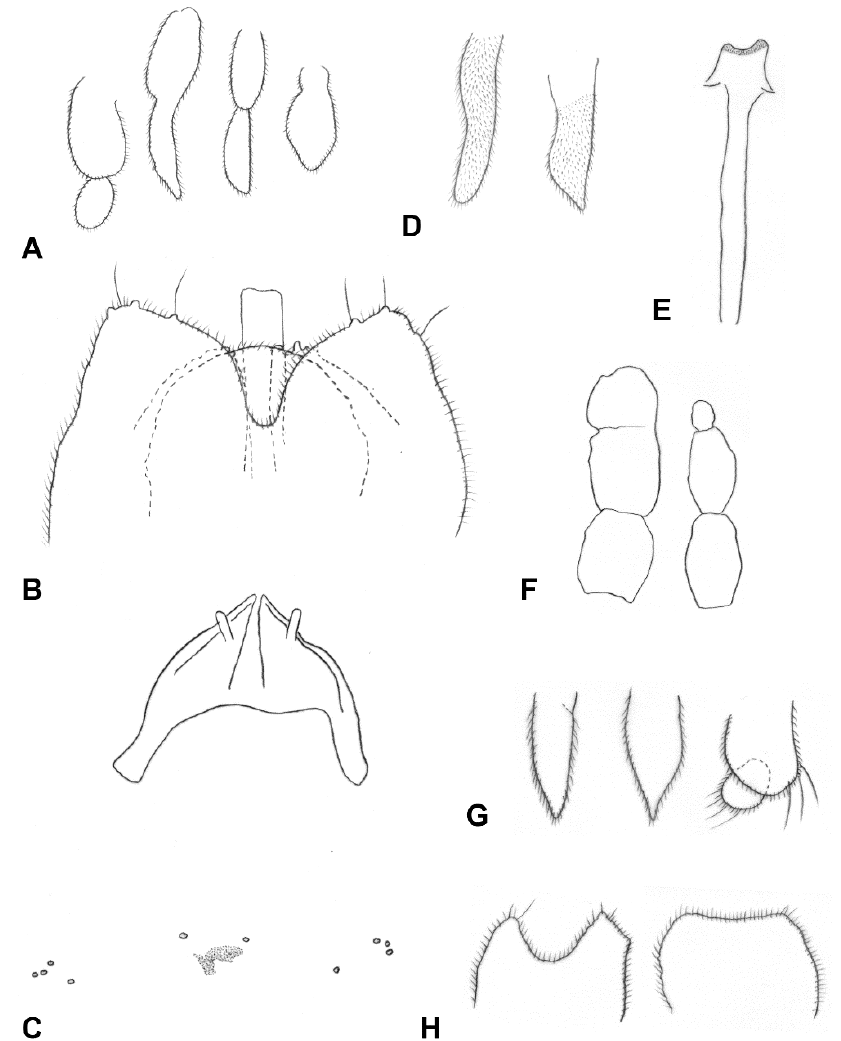
Figure 14. Ruschiola spp. ( A ) R. bubonis , variation in palpus morphology. ( B ) R. bubonis , male cerci, hypoproct, mediobasal lobes and aedeagus, dorsal. ( C ) R. bubonis , larval head, spatula and associated papillae. ( D ) R. quagga , variation in palpus morphology. ( E ) R. quagga , spatula. ( F ) R. timida , variation in shape of apical antennal flagellomeres. ( G ) R. timida , variation in palpus morphology. ( H ) R. timida , variation in shape of male hypoproct.